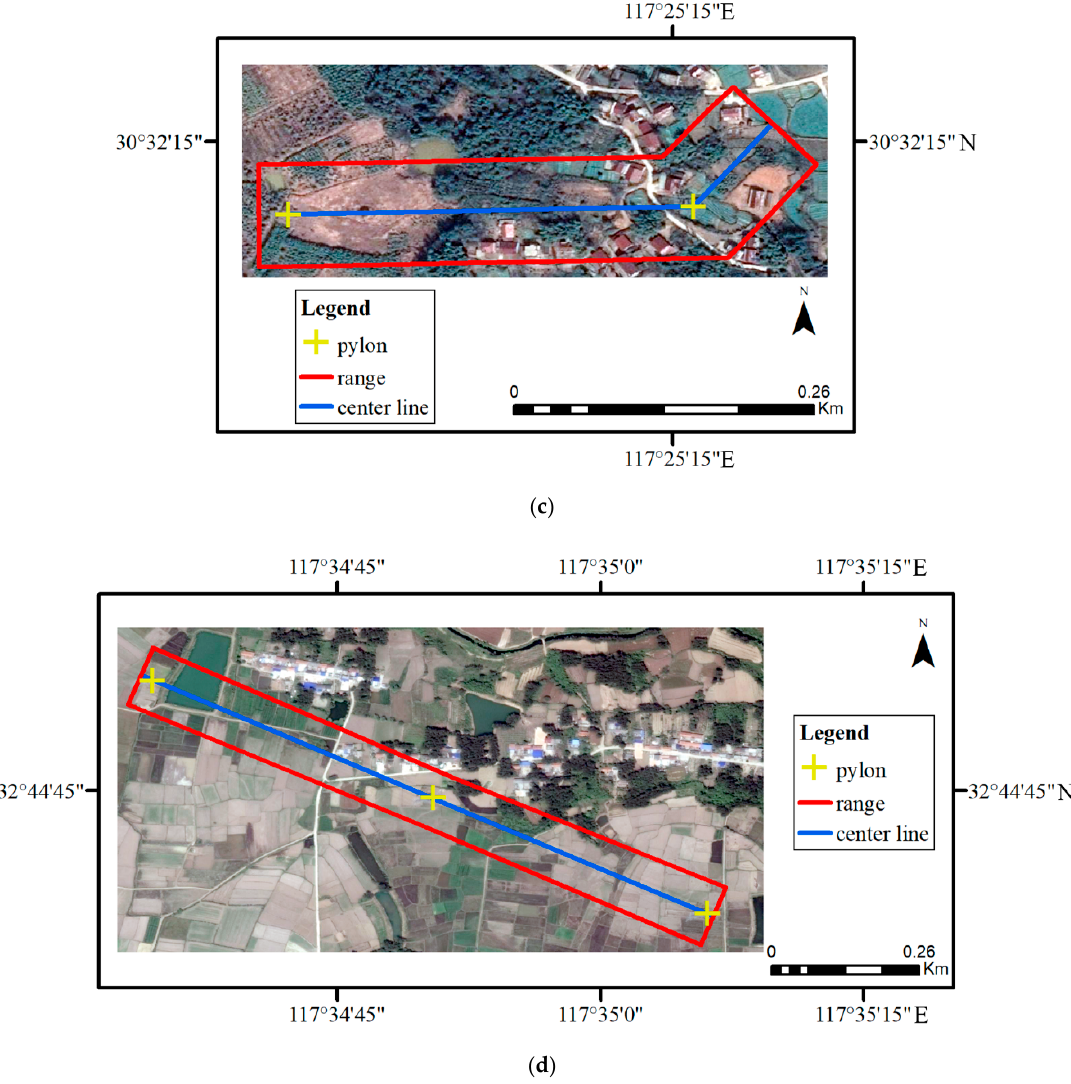
Figure 2. The location of datasets. ( a ) Training set; ( b ) site I of the test set; ( c ) site II of the test set; ( d ) site III of the test set. The base map is from Google Earth. The yellow plus sign denotes the pylon location. The polygon with red border indicates the extent of the dataset. The blue line is the center line of the dataset range and is the connection line of the pylon.